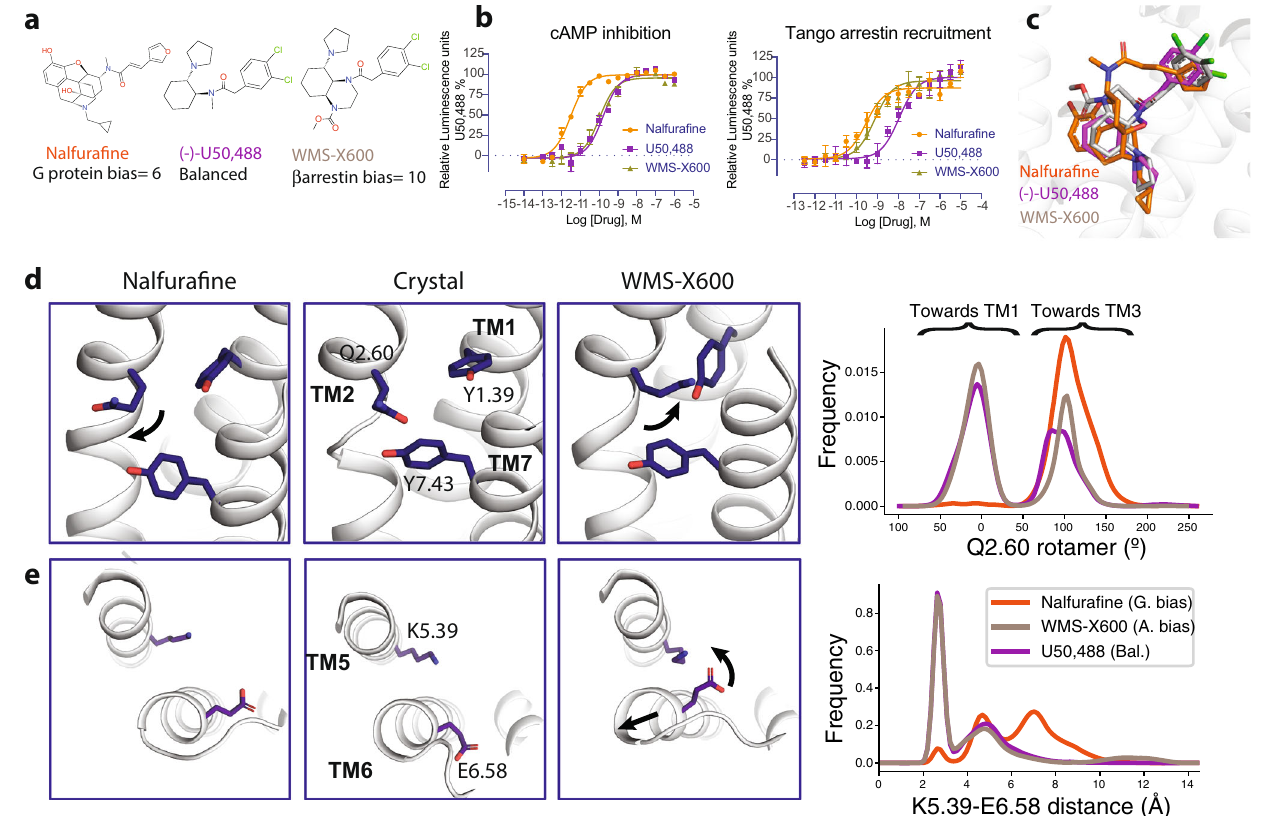
Fig.3|MoleculardynamicssimulationsoffunctionallyselectiveKORagonists. a Chemical structure of G protein biased agonist nalfura fi ne, balanced agonist U50,488,and arrestin-biasedagonist WMS-X600. U50,488 wasusedasa reference agonist that has a bias factor=1; G protein bias factor of nalfura fi ne (95%